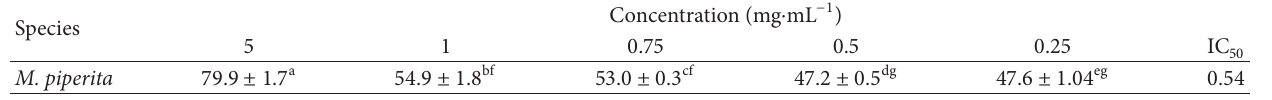
Table 2: Percentages results of antioxidant activity (% AA) of essential oil.